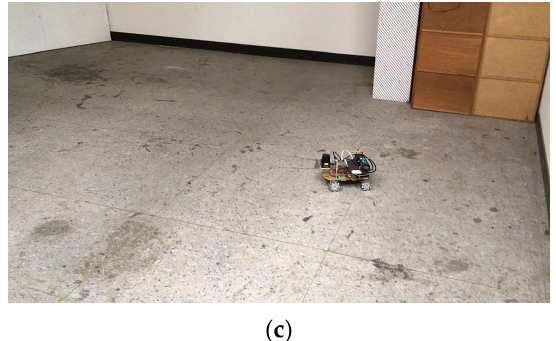
Figure 9. Scene-1: a robot moves in a clear environment with no obstacles. ( a ) Experimental environment . ( b ) Robot is moved in a guided rectangular path. ( c ) Robot is moved randomly .